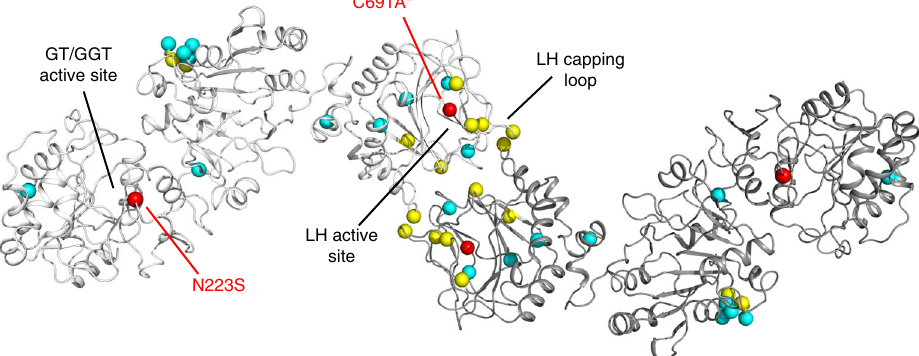
Fig. 4 Mapping of disease-related mutations identi fi ed in LH enzymes on the LH3 crystal structure. The positions of pathogenic mutations causing Ehlers- Danlos type VI syndrome in LH1 (cyan), Bruck syndrome type II in LH2 (yellow), and connective tissue diseases sharing phenotype features with osteogenesis imperfecta (red) in LH3 are shown as spheres on the LH3 dimer structure. Mutations N223S and C691A*, found on LH3, are labeled in red in one of the two monomers. A complete list of mutations reported in the literature and their signi fi cance based on evaluation of their mapping on the LH3 crystal structure is shown in Supplementary Table